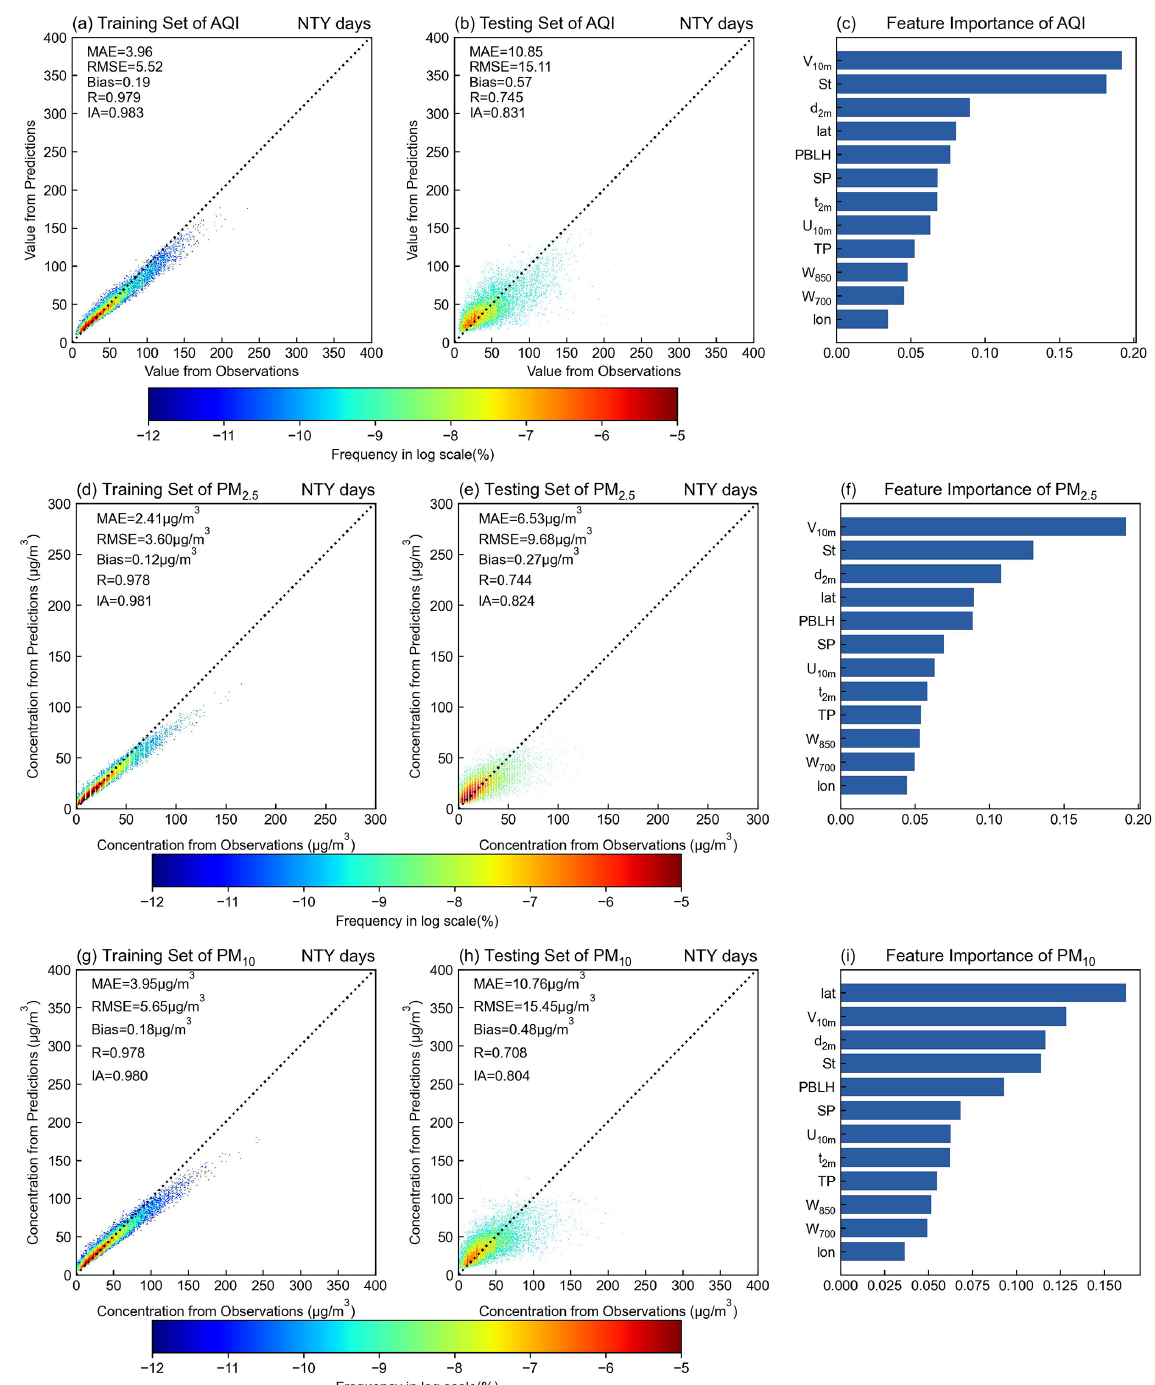
Figure 5. The results of NTY days’ AQI, PM 2 . 5 and PM 10 predicted by the RF model: (a) training set of AQI; (b) testing set of AQI; (c) feature importance of AQI; training set of (d) PM 2 . 5 and (g) PM 10 ; testing set of (e) PM 2 . 5 and (h) PM 10 ; feature importance of (f) PM 2 . 5 and (i) PM 10